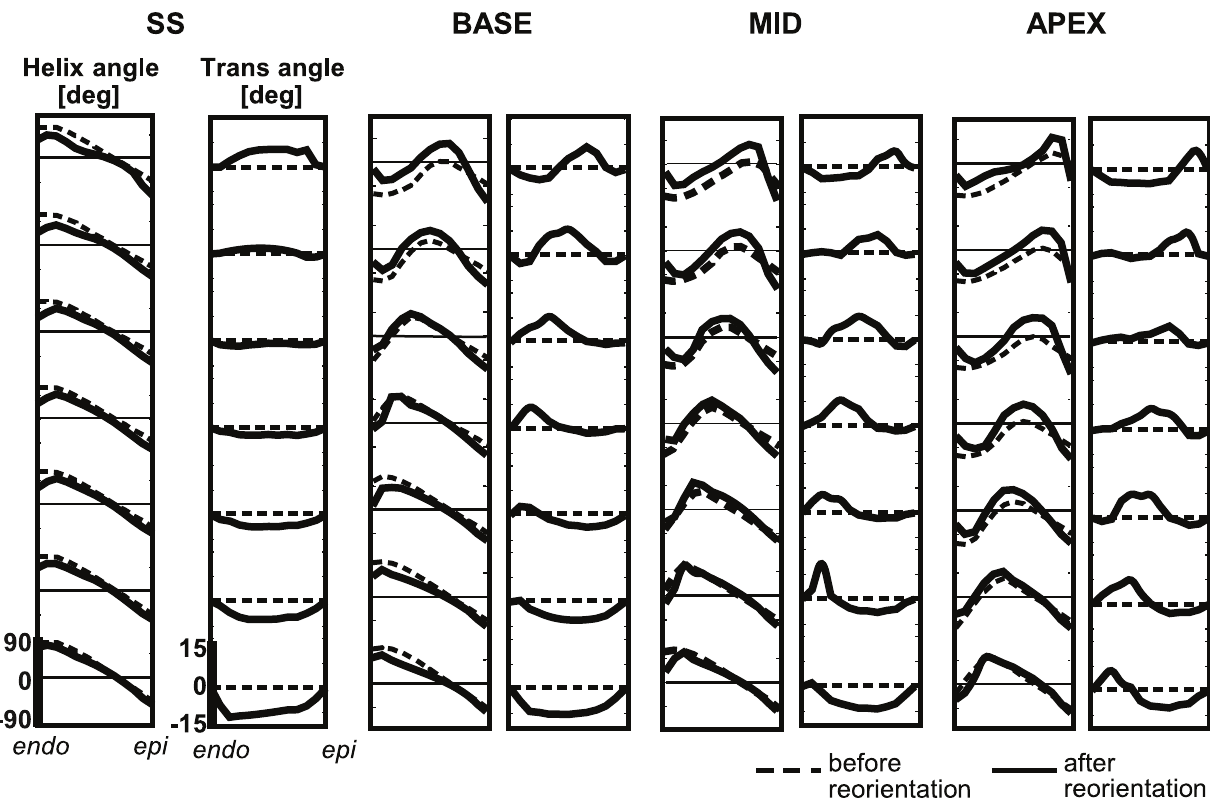
Figure 7. Transmural course in myofiber angles before ( 2 2 ) and after ( 2 ) myofiber reorientation. Results of simulation SS (left), and SIT simulations BASE , MID and APEX (right) are shown. Analysis is done at 7 different levels in the LV wall (see figure 3A).